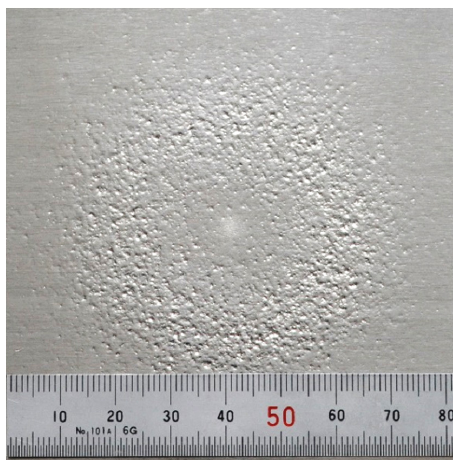
Figure 8. Typical treatment area by a fixed cavitating jet (pure aluminum, nozzle diameter d = 2 mm, upstream pressure of nozzle p 1 = 30 MPa, downstream pressure of nozzle p 2 = 0.1 MPa, standoff distance s = 262 mm, exposure time t = 1 min) [3].